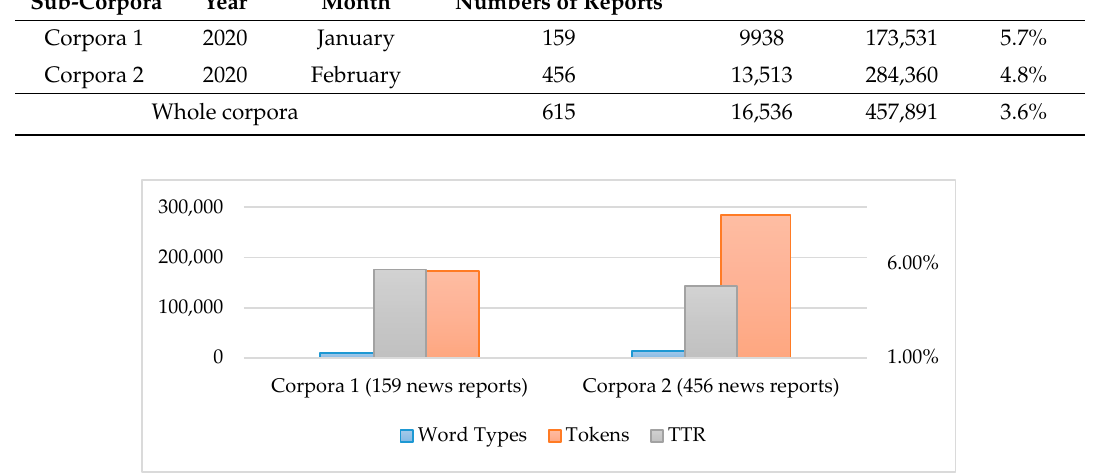
Table 2. An example of the word list from the input corpora (partial data).